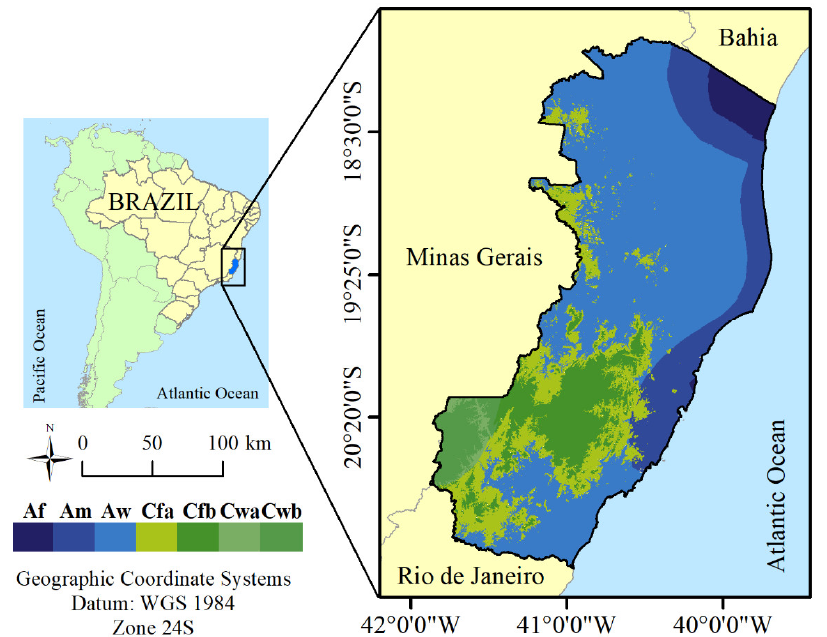
Figure 1. Study area geographic location containing the Köppen climate classification.